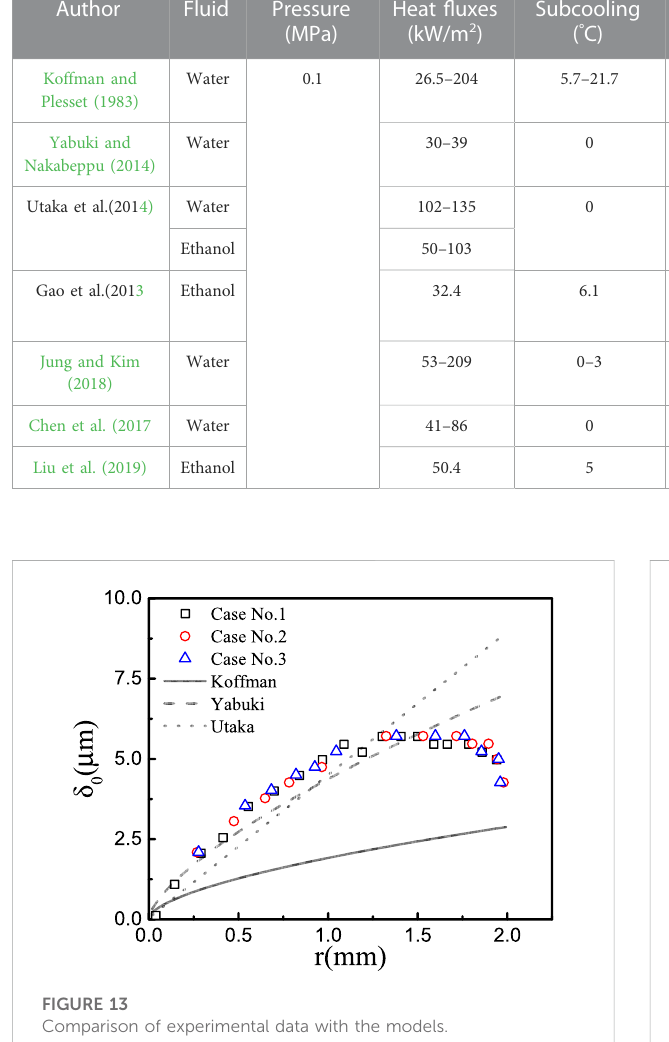
Relation between maximum thickness and ratio r d /r b,1